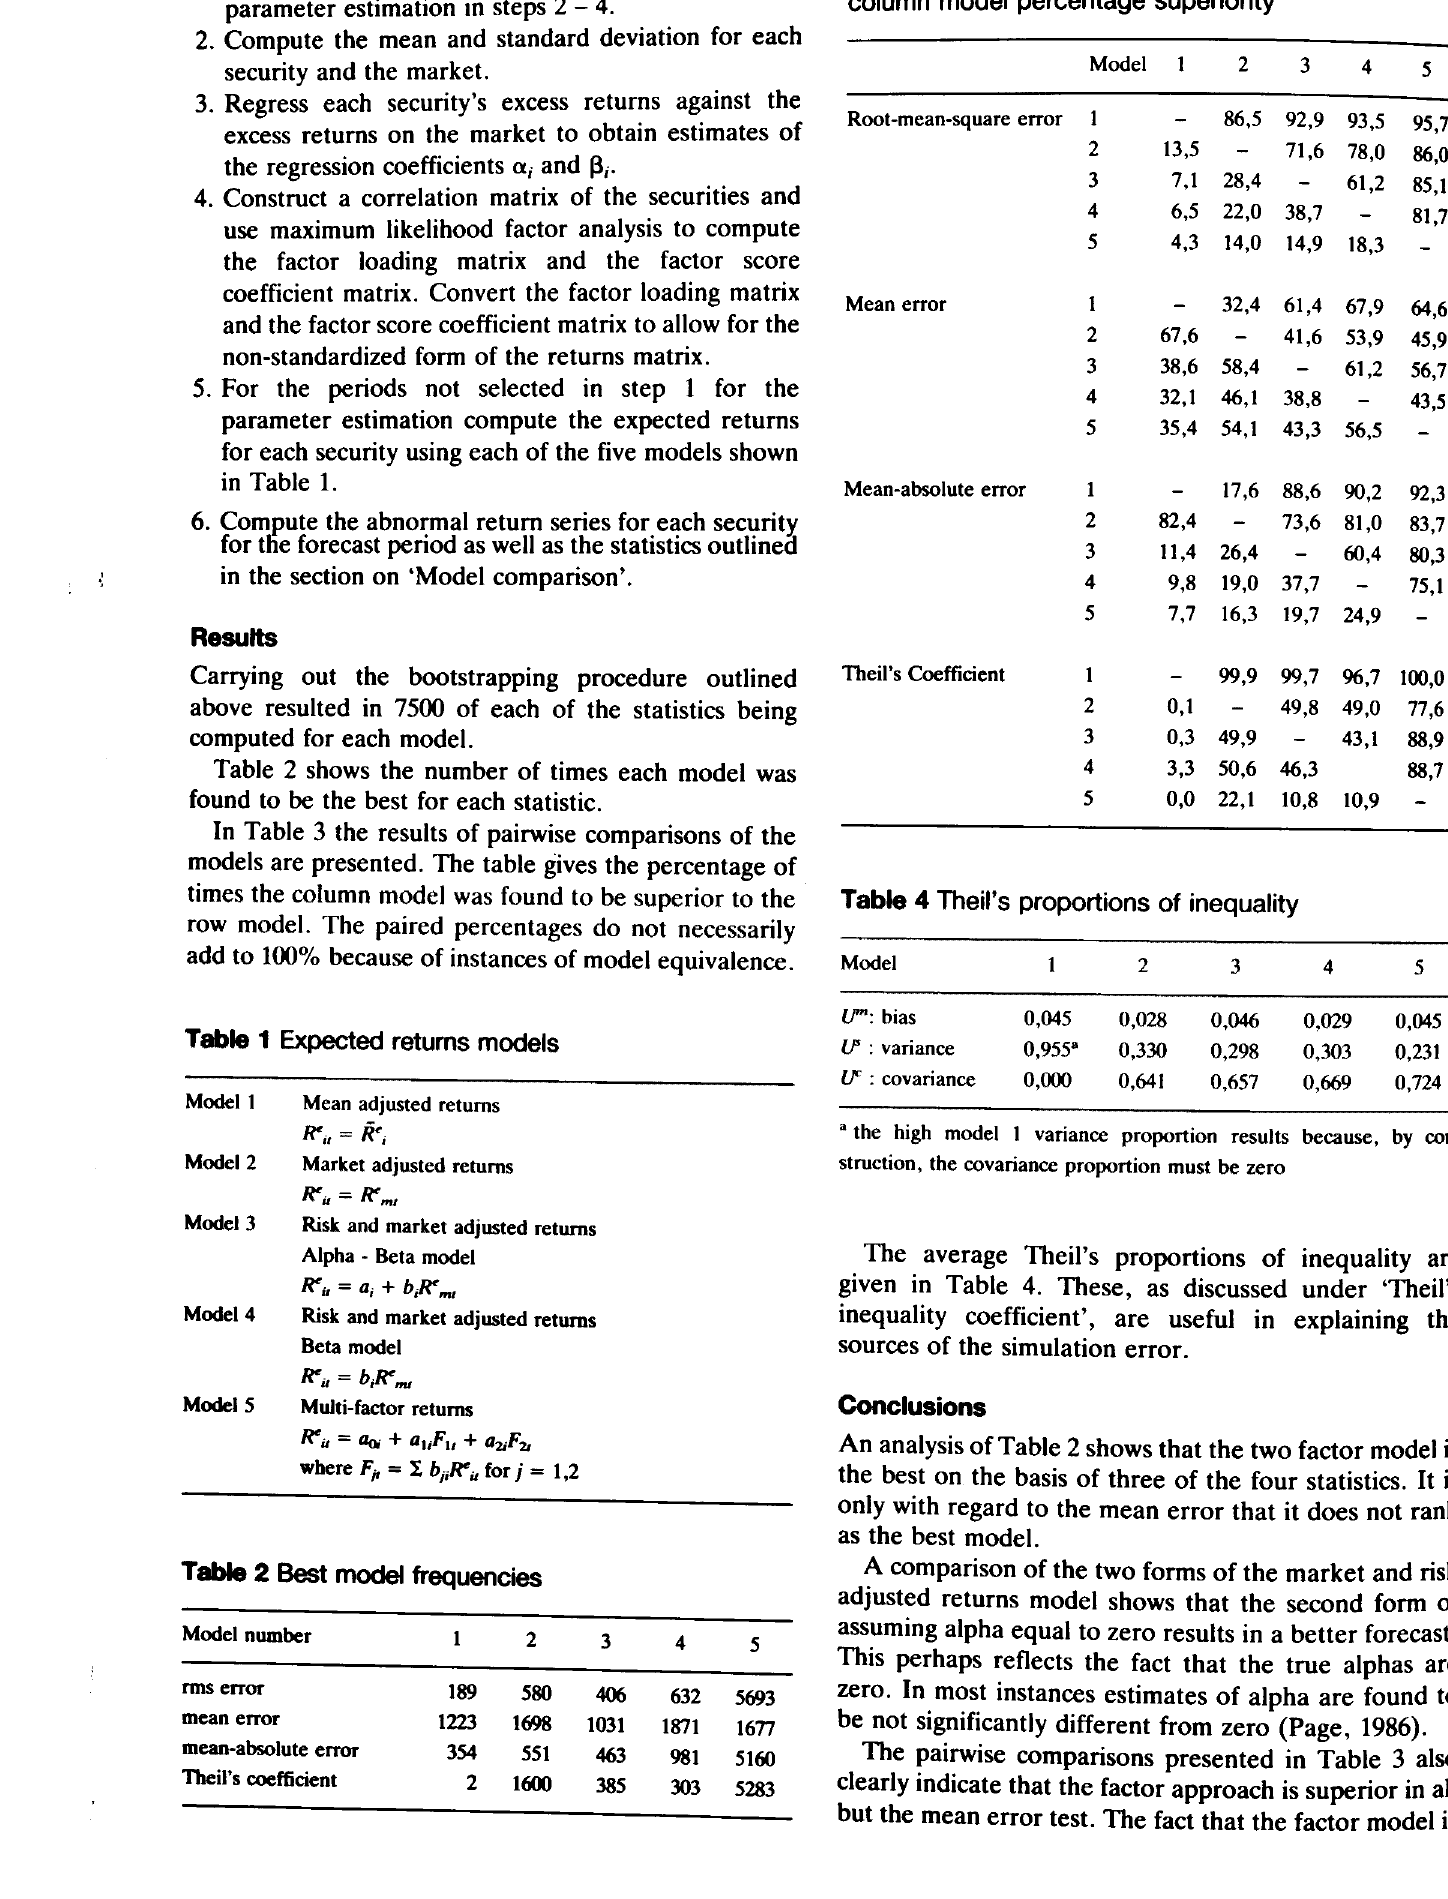
Table 3 Pairwise model comparison showing the